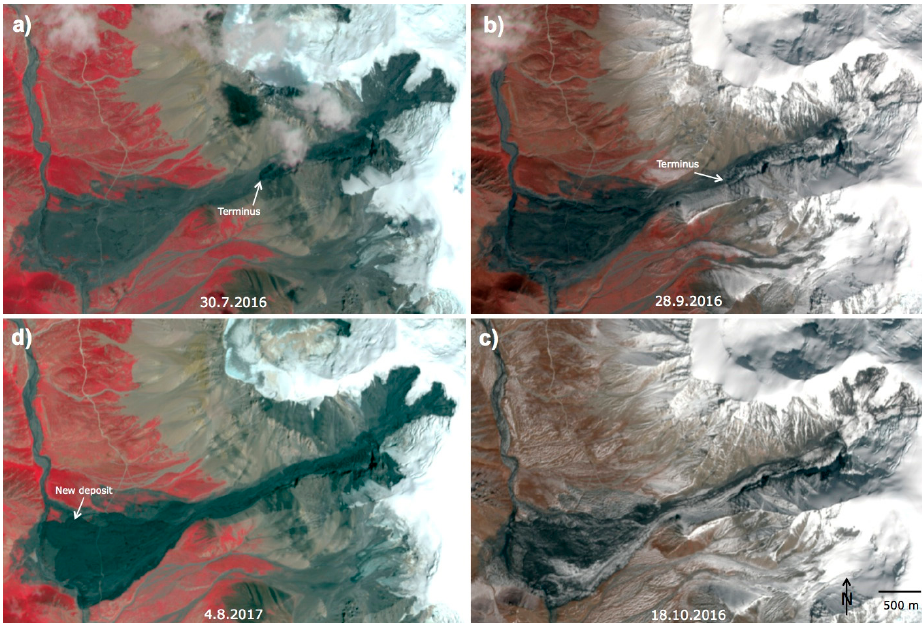
Figure 10. Time series of the 2016 glacier collapse as seen on false-colour composite images (near infrared, red, and green as RGB) acquired by Sentinel-2. (a) The image from 30 July 2016 shows the glacier during its surge. (b) Maximum extent on 28 September 2016 about 1 week before the collapse. (c) After the collapse on 18 October 2016. (d) The deposit from the last collapse (in darker shades of grey) in summer 2017. The destroyed country road (that is also used as a pilgrim path) has been re-established over the fresh deposit. Image source: Copernicus Sentinel data 2016 and 2017.